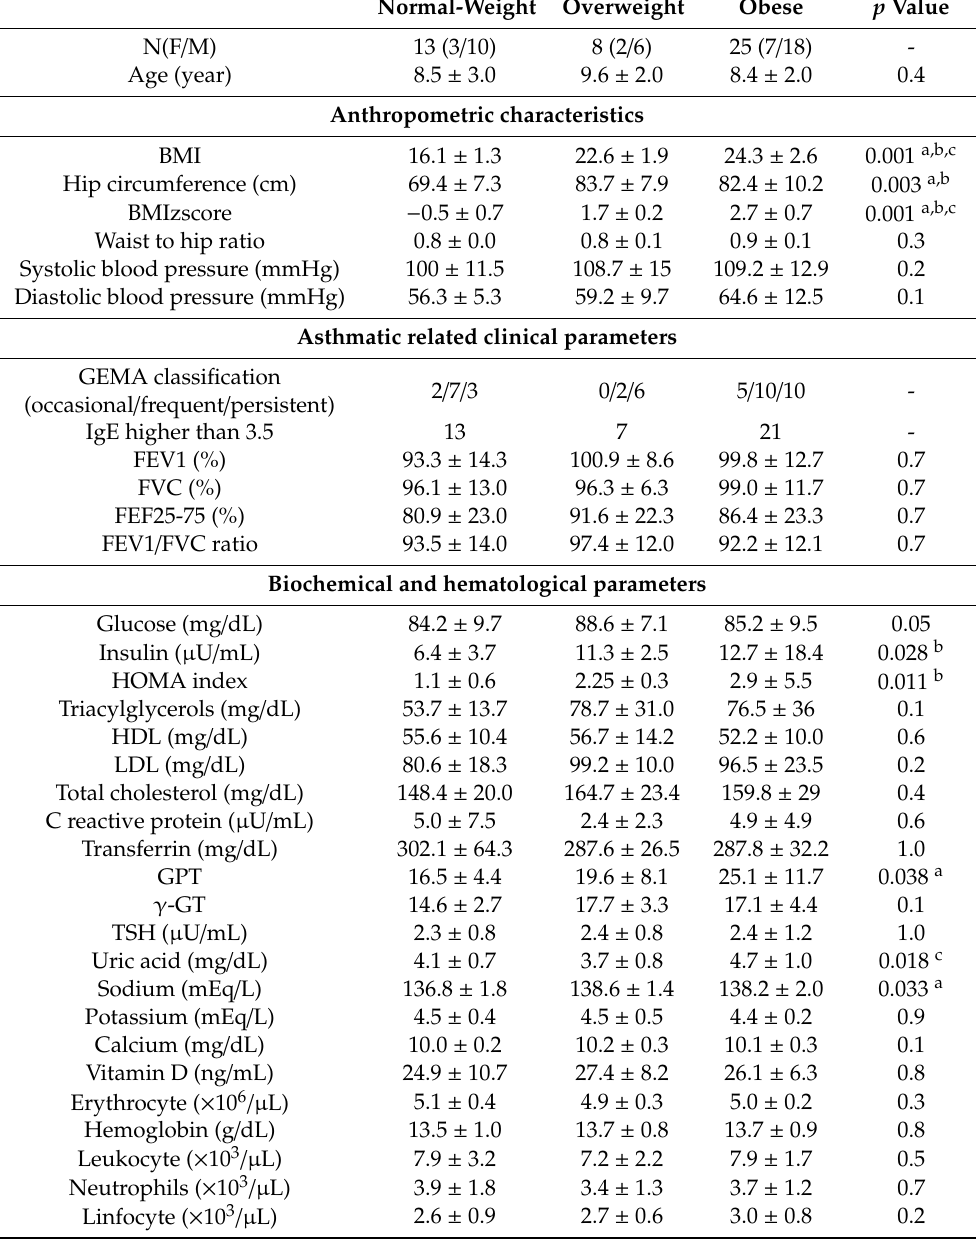
Table 1. Anthropometric, clinical, biochemical and hematologic characteristics of the BIOASMA cohort. Normal-Weight